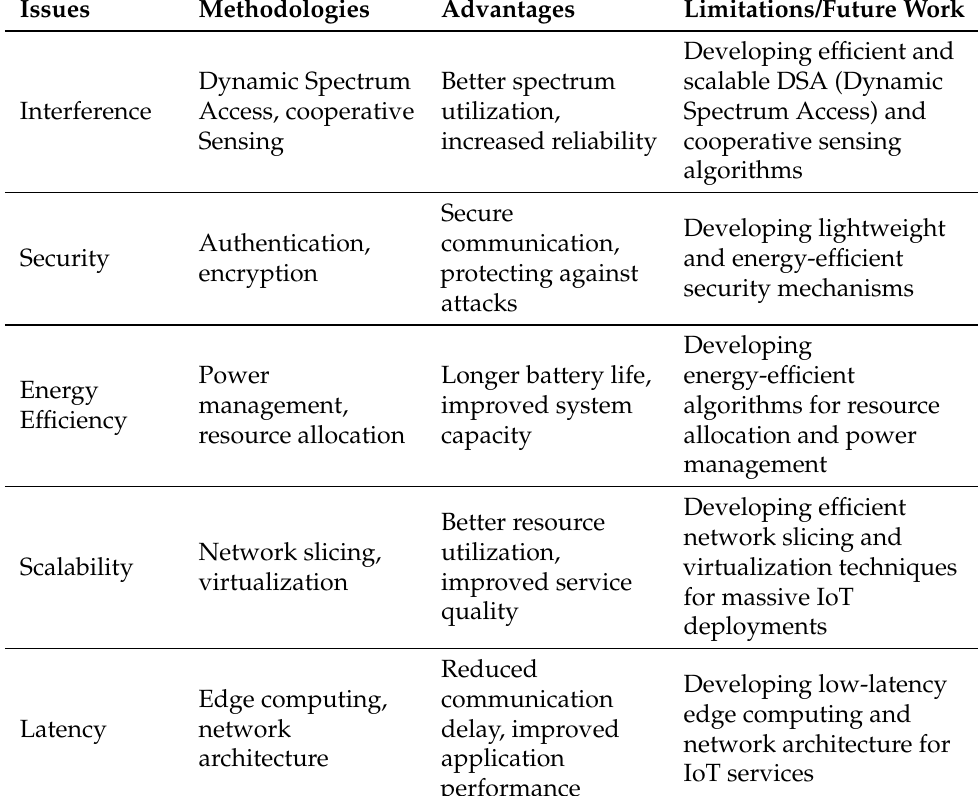
Table 12. Future research challenges in 5G for IoT services.